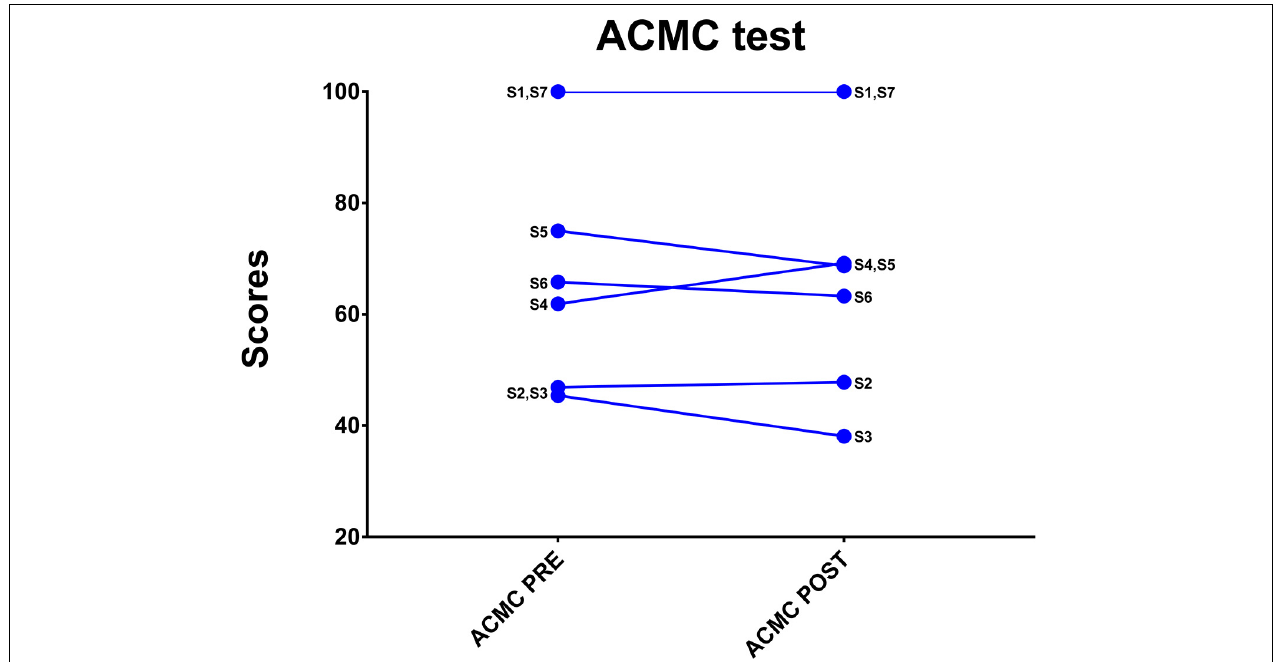
FIGURE 4 | The ACMC-scores for each participant at pre-tests and